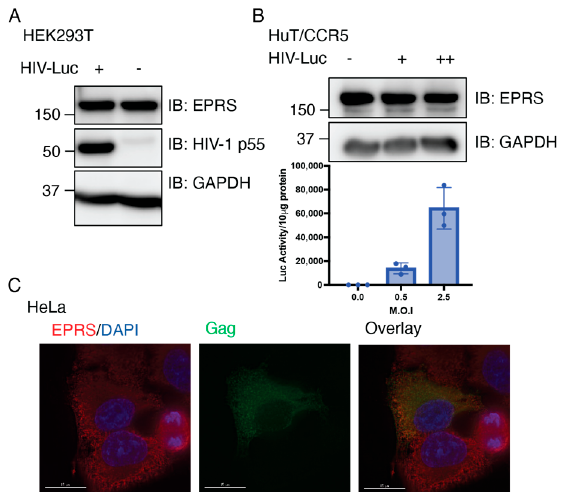
Figure 6. EPRS protein levels are not altered in cells infected with single-cycle HIV-1. ( A ) Immunoblot showing level of EPRS in HEK293T cells uninfected or infected with HIV-Luc/VSV-G with M.O.I. of 5. ( B ) Immunoblot showing level of EPRS in HuT/CCR5 cells uninfected or infected with HIV- Luc/VSV-G with MOI of 0.5 (+) or 2.5 (++). Graph shows level of infectivity as measured by luciferase production. ( C ) Immunofluorescence imaging of Gag-GFP and EPRS expression in HeLa cells infected with